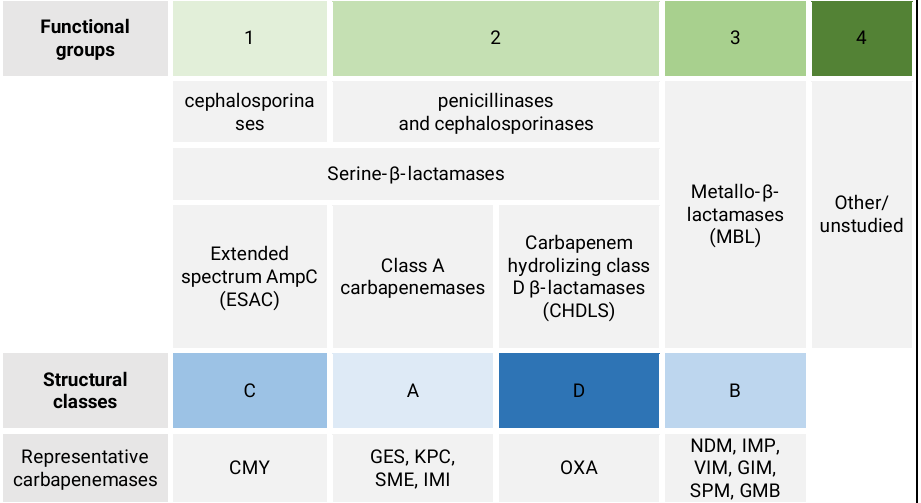
Figure 1. Comparison of β -lactamases classification systems with representative carbapenemases (AmpC—ampicillin chromosomal cephalosporinase, CMY—cephamycin-hydrolyzing β -lactamase,